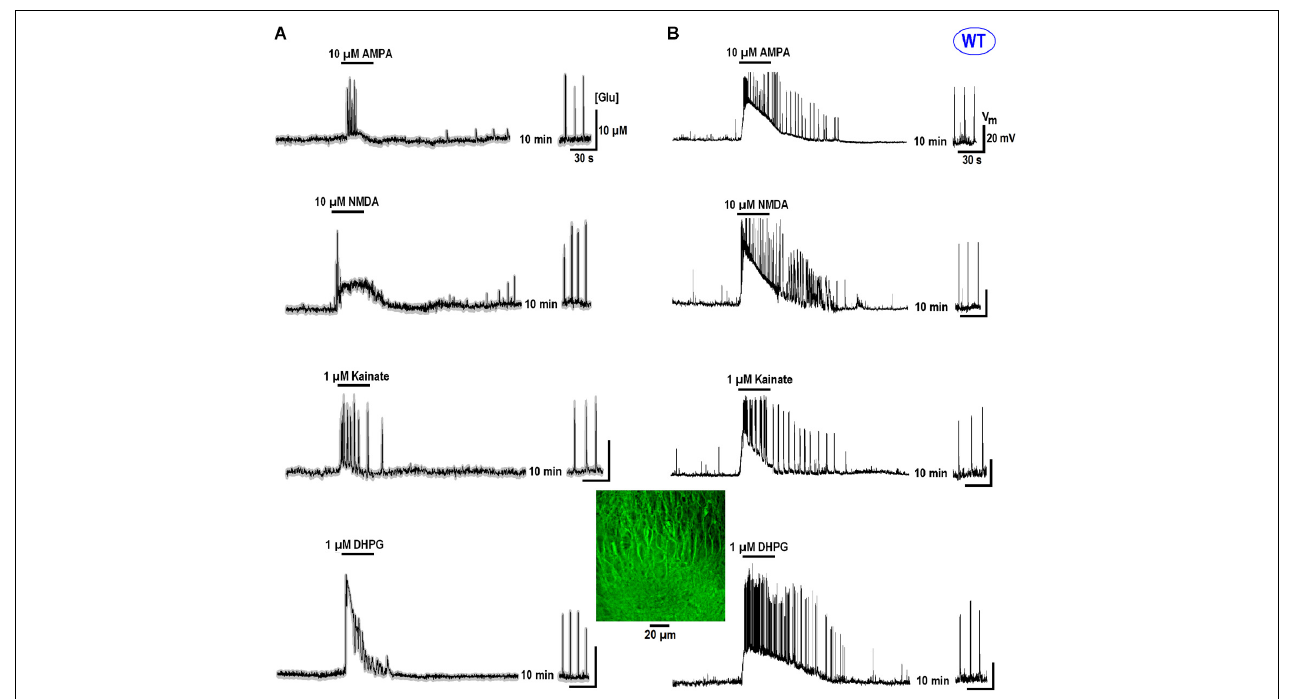
FIGURE 1 | GluR agonists transiently increase ambient glutamate in CA1 neurons and induce repetitive glutamate spikes in WT. (A) Changes in ambient glutamate (mean traces were obtained from 12 regions of interest that encircled the neurons expressing iGluSnFr). Average traces are overlaid onto gray background showing ± SEM. (B) One neuron in each image field was patched and the traces on the right present representative current-clamp recordings. The ambient glutamate changes on the left and voltage trajectories on the right were measured simultaneously. In naïve slices from WT animals, repetitive glutamate spikes were observed only in 14 from 112 slices examined (see also the insets in Figure 4 ). After recovery, the regular spikes appeared in WT (continuation of traces after 10 min wash-out). The calibration bar scales are indicated only in the first panel. The inset (middle bottom) shows a typical structure of CA1 layer in WT. Group summary is given in Table 1 that presents durations of augmentation and depression for global glutamate transients, and the amplitudes and frequency of glutamate spikes and neuronal bursts 10 min after the application of GluR agonists.